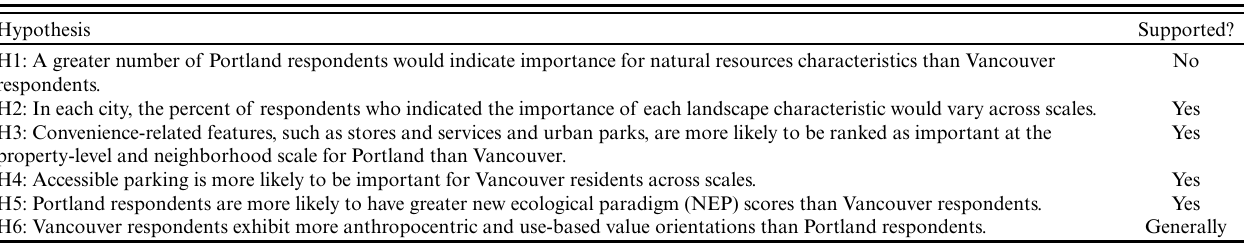
Table 1 . Hypotheses used to evaluate differences between Portland and Vancouver across three scales, and results of analysis. Hypothesis